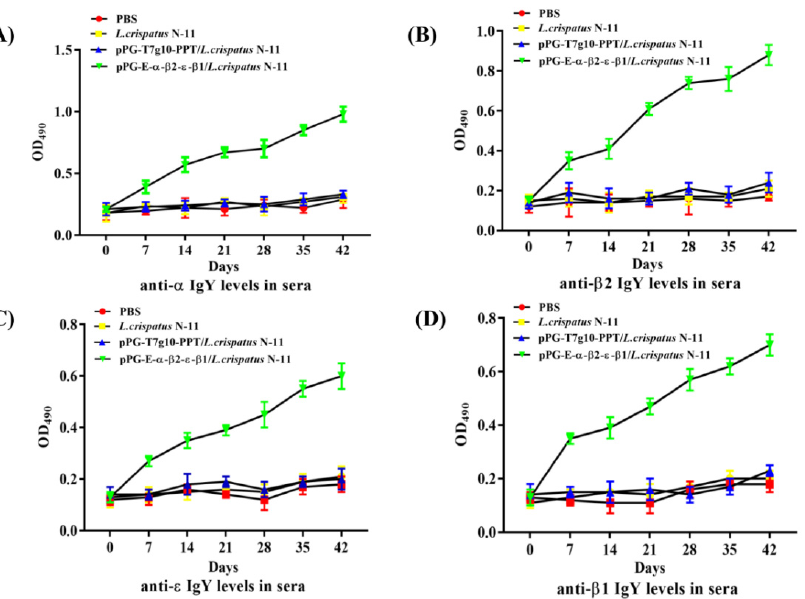
Figure 4. Antigen-specific IgY antibody level in sera of chickens immunized with pPG-E- α - β 1- ε - β 2/ L. crispatus N-11 was analyzed using ELISA. The intestinal mucus samples ( n = 3) were collected on days 0, 7, 14, 21, 28, 35, and 42 from each group of chickens. ( A ) Anti- α specific IgY; ( B ) anti- β 2 specific IgY; ( C ) anti- ε specific IgY; ( D ) anti- β 1 specific IgY. Data are presented as the mean ± standard error in each group.